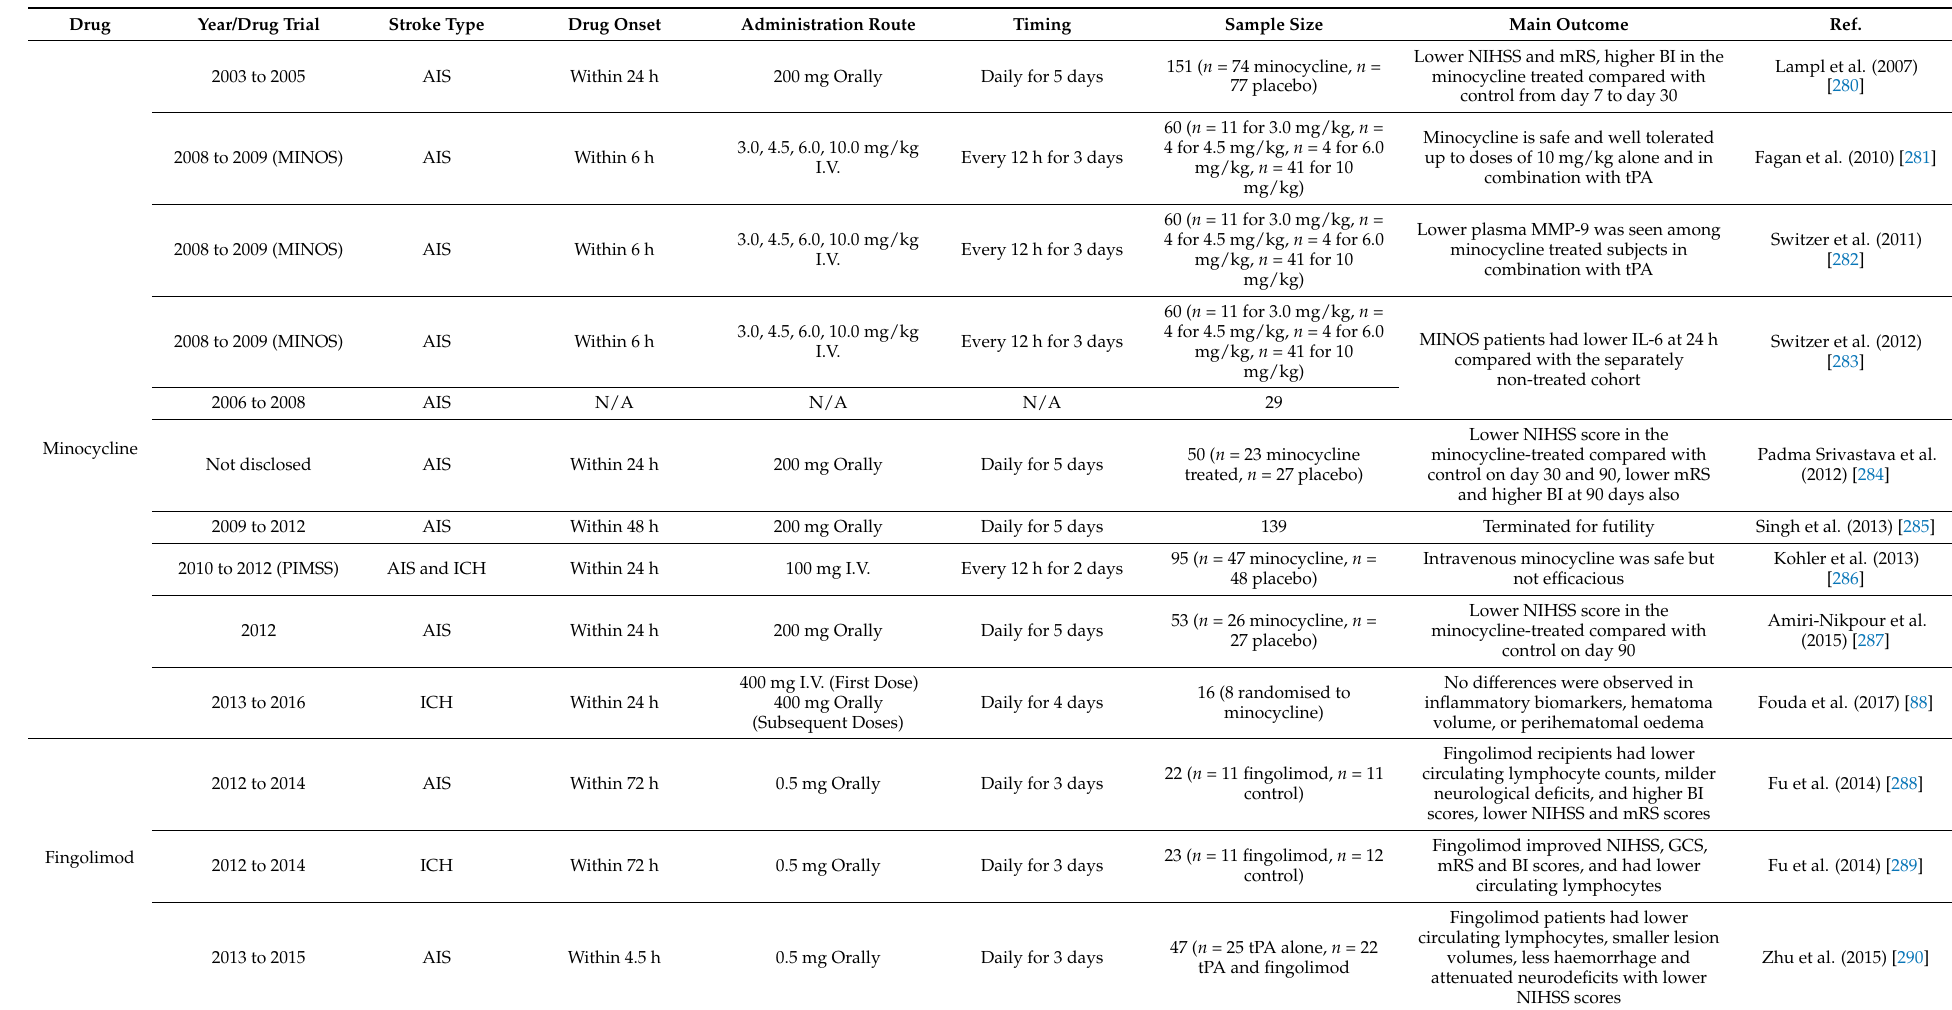
Table 2. Existing clinical data on the immunomodulatory drugs discussed in this review: Minocycline, Fingolimod, Natalizumab, and